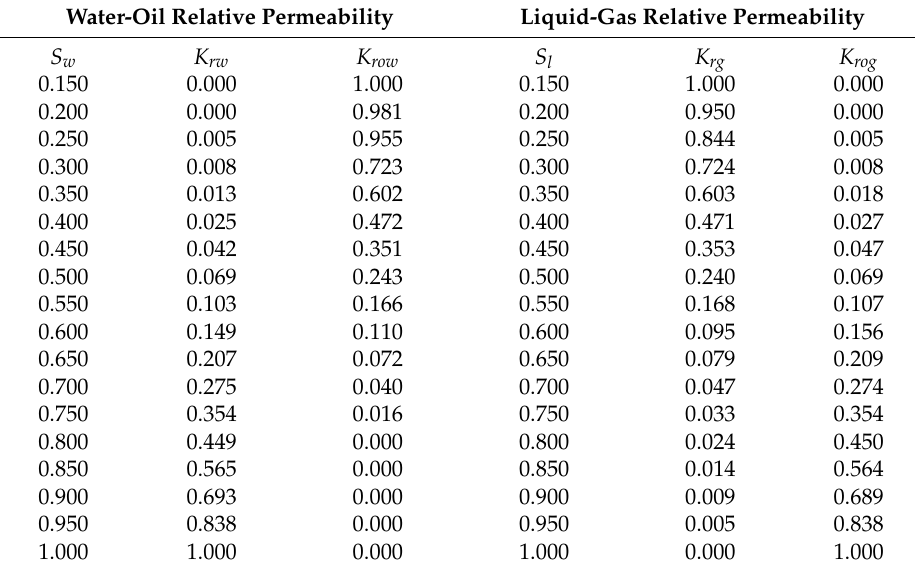
table; K rog : relative oil phase permeability in the liquid-gas table.